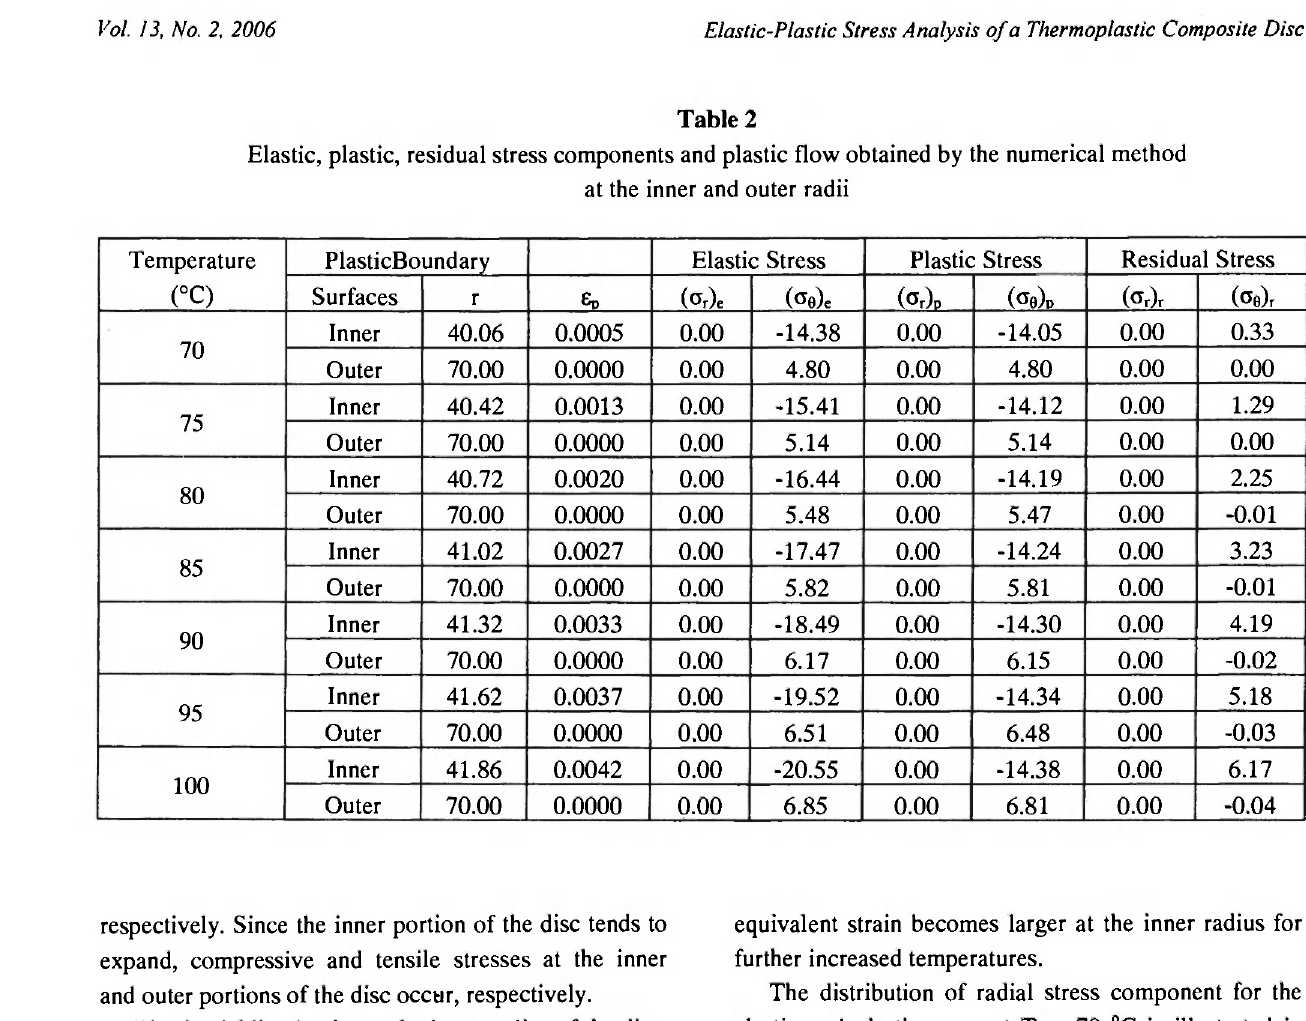
The distribution of radial stress component for the elastic and plastic cases at T, = 70 °C is illustrated in Figure 6. a r is not large for all the given cases. The distribution of the tangential stress components for elastic and plastic cases at Τ = 70 °C is shown in Figure 7. The residual stress component of σ